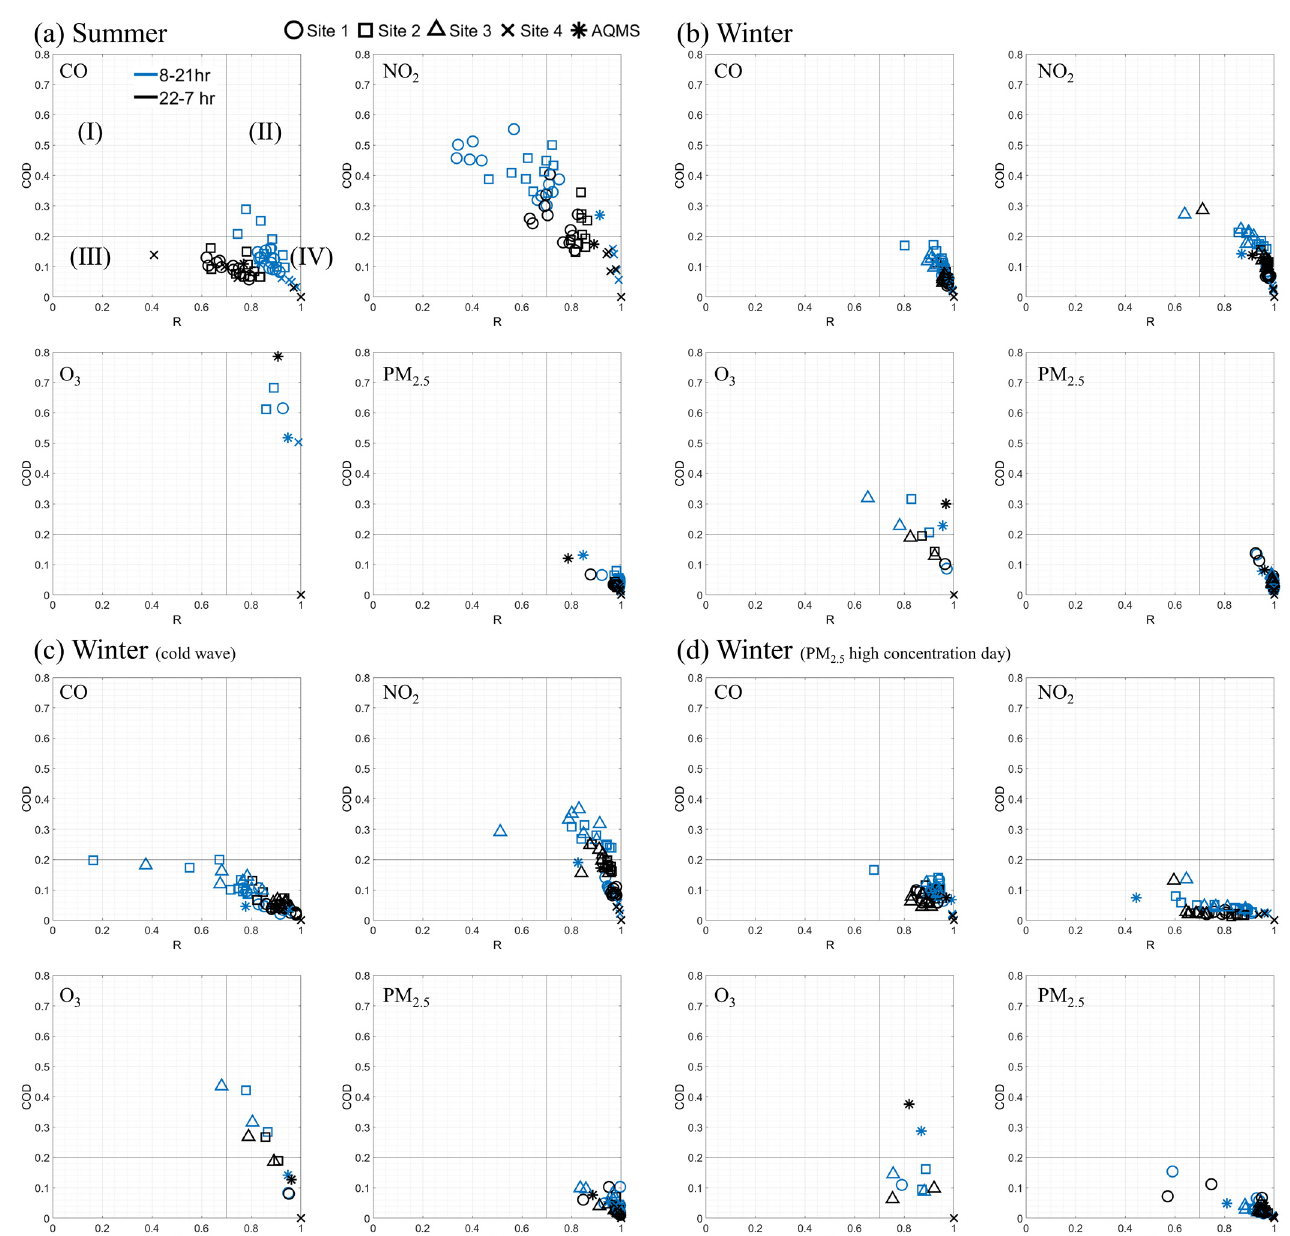
Figure 8. Plots of COD vs. R at each sensor-node location. Blue denotes daytime (08:00–21:00) and black represents nighttime (20:00–07:00). Circles denote the sensor-nodes located at Site-1, squares denote the sensor-nodes located at Site-2, triangles denote the sensor-nodes located at Site-3, x denote the sensor-nodes located at Site-4, and the asterisk indicates the AQMS. (I) represents a spatially and temporally heterogeneous distribution and (IV) represents a spatially and temporally homogeneous distribution.